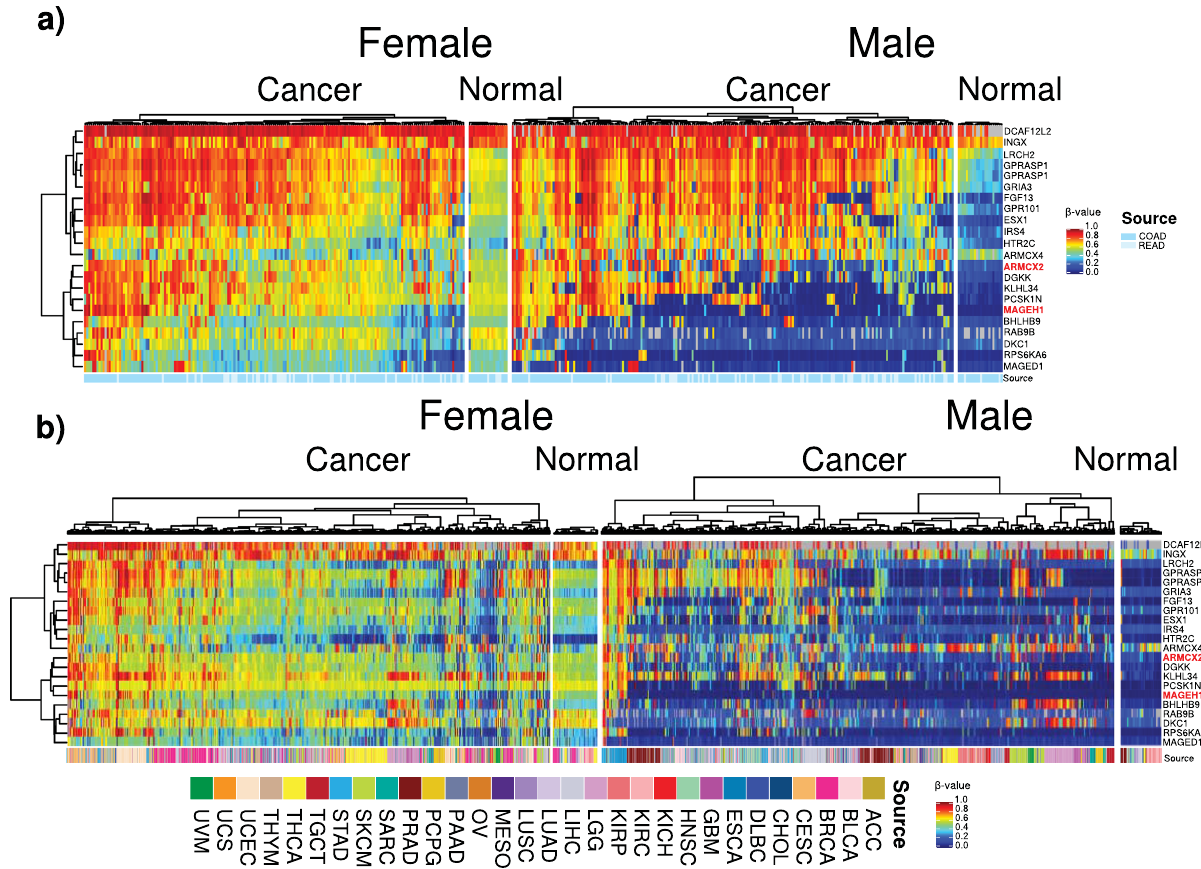
Fig. 4 Hypermethylation of CpGs that are unmethylated in non-cancer human tissues is replicated in TCGA samples for colon and rectal adenocarcinoma as well as other cancer types. Heatmaps showing DNA methylation level as measured by the 22 HCT116 GSK5032-resistant probes (rows) in ( a ) COAD/READ samples (columns) ( n = 402 COAD/READ tumor samples, n = 41 adjacent normal samples) ( b ) and a panel of cancer samples other than COAD/READ from TCGA data for identi fi ed probes that were unmethylated in non-cancer human tissues. A color spectrum of blue to red indicates low to high levels of DNA methylation ( β -values ranging from 0 to 1). Samples were organized fi rst by biological sex and then tissue type (cancer/ normal). Genes discussed in the main text are labeled in red. Tumor type annotation is plotted beneath each heatmap, with color code explained as ‘ source ’ ( n = 8790 human tumor samples, n = 714 adjacent normal